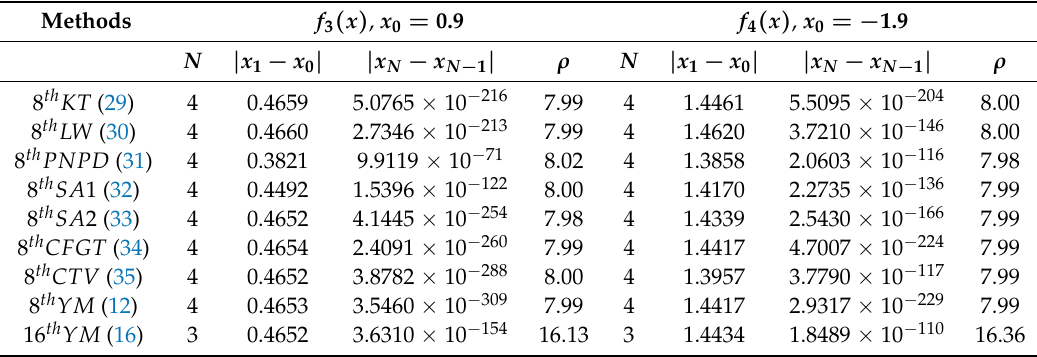
Table 4. Numerical results for nonlinear